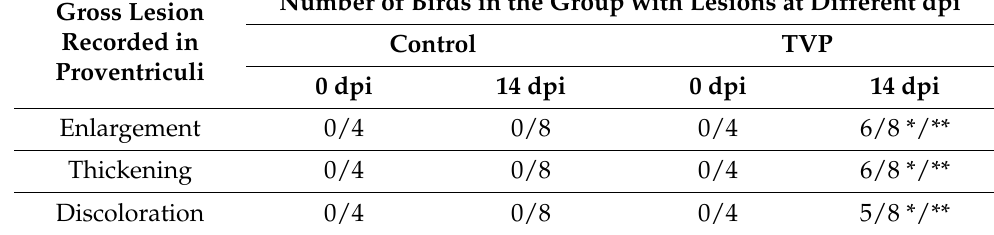
Table 2. Prevalence of gross lesion in birds of TVP and Control